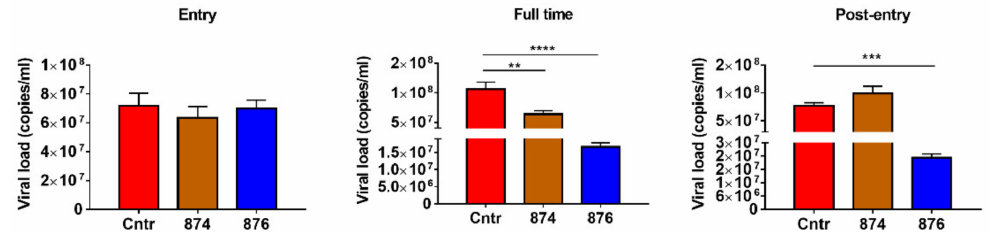
Figure 3. Time-of-drug-addition Assay. Vero E6 cells were treated with the compounds at different time points of the viral replication cycle as described in the Materials and Methods chapter. For all experimental groups, cells were infected with SARS-CoV-2 at an MOI of 0.01. Viral RNA copies in the supernatant were quantified by qRT-PCR at 18 h post-infection. All results are shown as mean ± SEM ( n = 3). One-way ANOVA with Tukey’s post hoc test: ** p < 0.01, *** p < 0.001 and **** p <